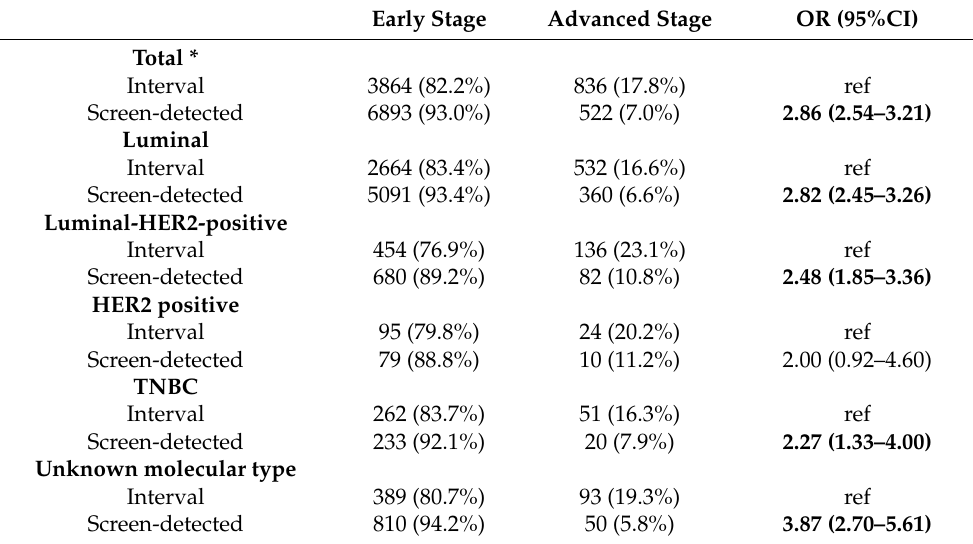
Table 2. Univariate logistic regression model for the comparison of the likelihood of early-stage breast cancer at diagnosis between screen-detected and interval breast cancer. ( n = 12,115).